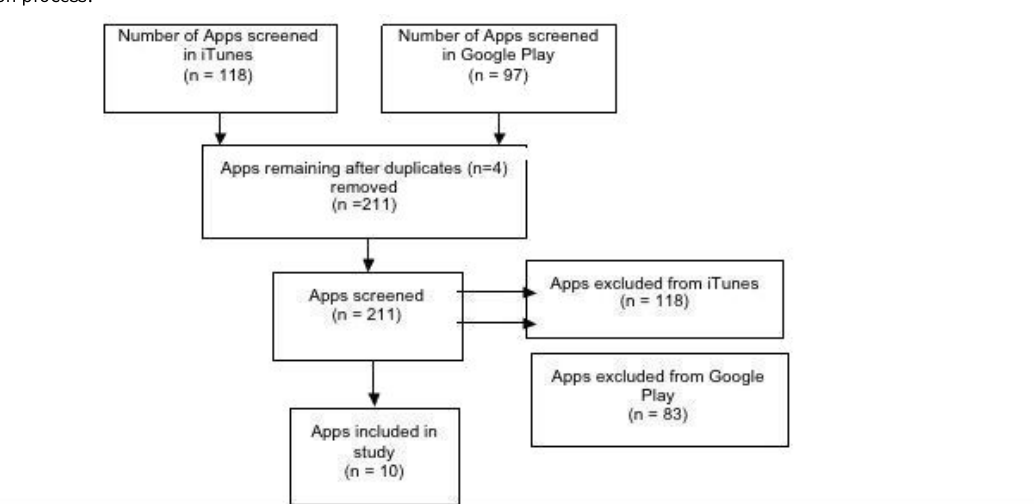
Figure 1. App selection